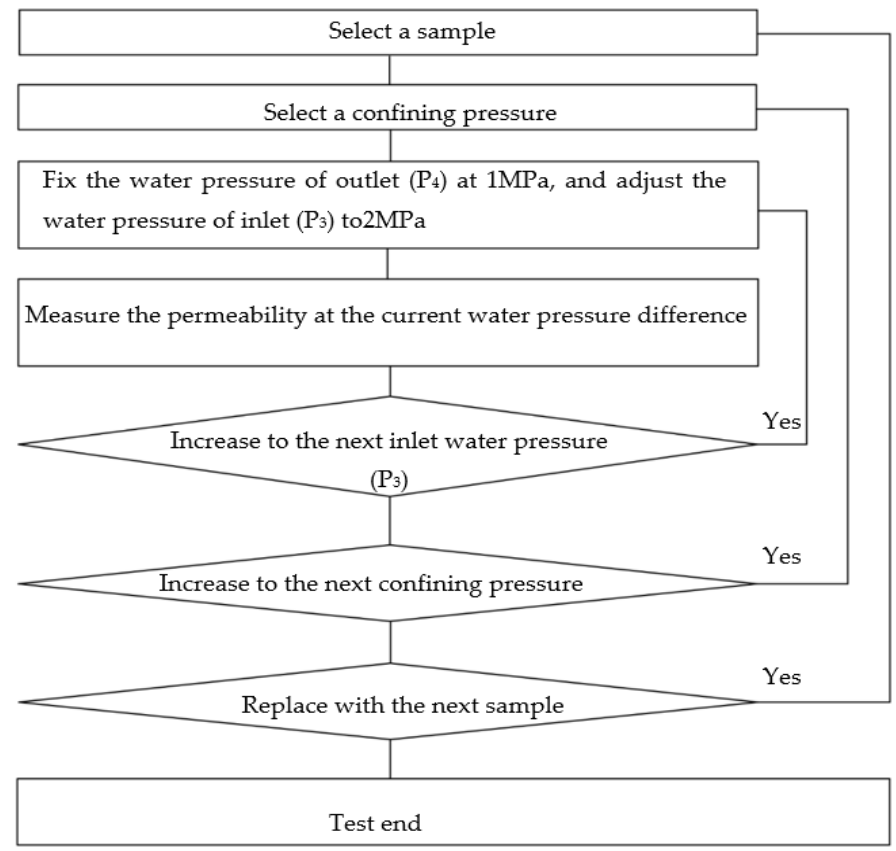
Figure 8. The flow chart of permeability testing under different water pressures.